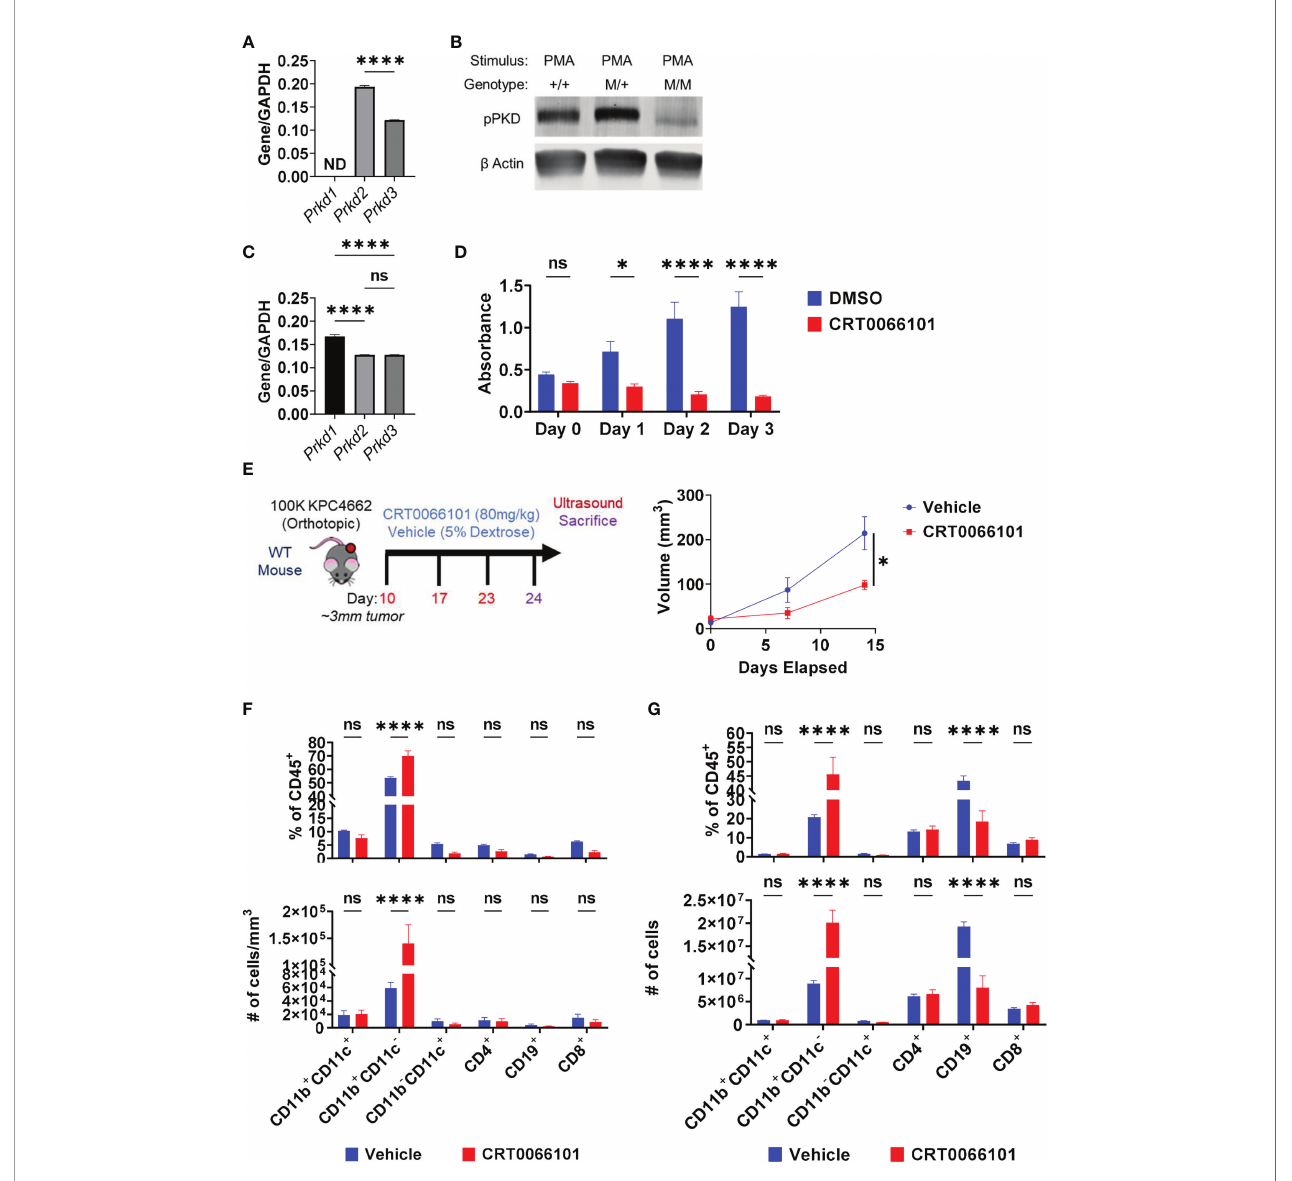
FIGURE 5 | Protein Kinase D regulates PDAC growth in immunocompetent mice. (A) RT-PCR analysis of PKD isoform expression in WT splenic B cells. ND=not detectable. N=3. (B) Phospho-PKD (S744/748) immunoblot of PMA-stimulated splenic B cells that are WT (+/+), heterozygous (M/+), or homozygous (M/M) for S707A/S711A mutation in Prkd2 . (C) RT-PCR analysis of PKD isoform expression in KPC4662 cells. N=3. (D) MTT proliferation assay of DMSO or CRT0066101 treated KPC4662 cells in vitro . N=5. (E) Treatment schema and study design (left). Brie fl y, 10 days post-KPC4662 injection, WT mice were strati fi ed into groups and treated with CRT0066101 or vehicle QOD by oral gavage. Mice were treated for 2 weeks before sacri fi ce at day 24 post-tumor injection. Orthotopic KPC4662 tumor volumes of CRT0066101 and vehicle treated mice as measured by ultrasound imaging (right). (F) Frequencies of indicated CD45 + immune populations isolated from tumors (top) and cell number per mm 3 of tumor (bottom) from vehicle and CRT0066101 treated mice. (G) Frequencies of indicated CD45 + immune populations isolated from tumors (top) and cell number (bottom) from vehicle and CRT0066101 treated mice. Error bars indicate SEM; p values in (A, E) were calculated using unpaired t-test; p values in (C) were calculated using one-way ANOVA; p values in (D, F, G) were calculated using two-way ANOVA. NS, non-signi fi cant, *p<0.05, **p<0.005, ***p<0.001 ****p<0.0001. Experiments were performed using 7 – 8-week-old mice of indicated